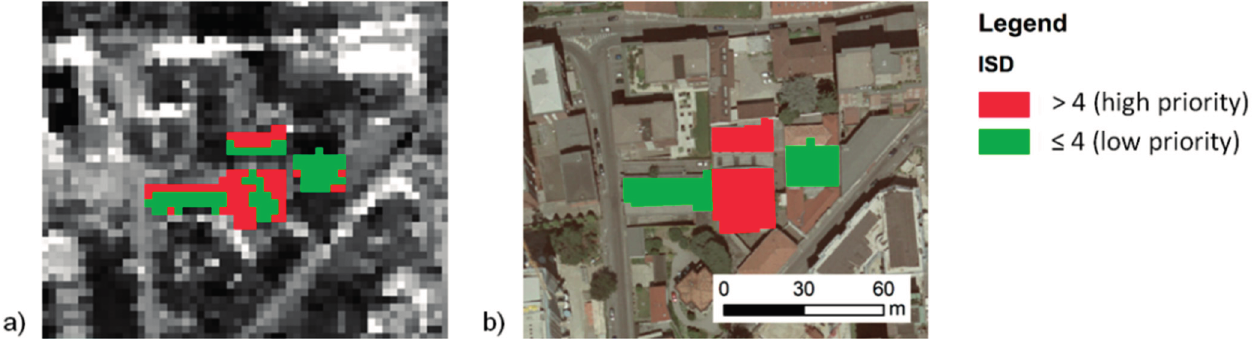
Figure 8. ( a ) Detail of the ISD map on four buildings mapped on the MIVIS image: pixels with ISD > 4 are represented in red, pixels with ISD ≤ 4 in green; ( b ) Each roof was assigned to one unique ISD class and overlaid to an ortophoto: red roofs correspond to roofs with high removal priority (ISD > 4), green roofs to those with low removal priority (ISD ≤